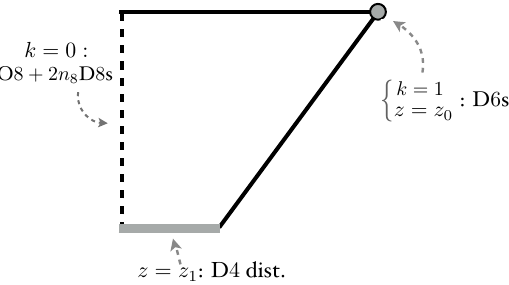
Figure 3 . A cartoon of M 3 for the range z 2 [ z 1 ; z 0 ]. Compared to the solution in (cid:12)gure 1, the lower range for z is at z = z 1 , where a distribution of D4-branes appears; in other words, the D4-branes in (cid:12)gure 1 have spread out in the k; directions as well.  =